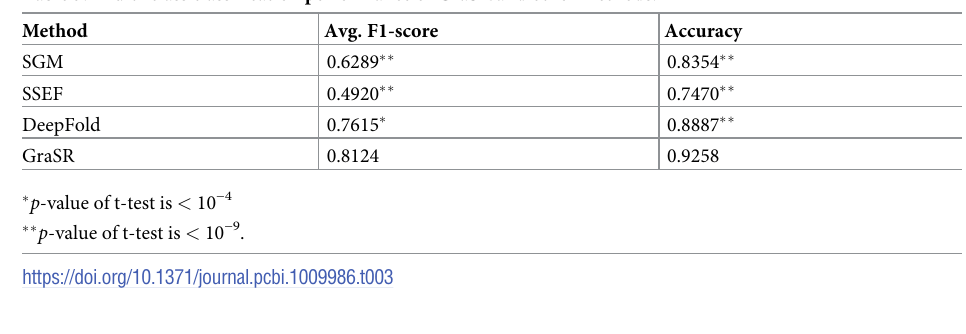
Table 3. Multi-class classification performance of GraSR and other